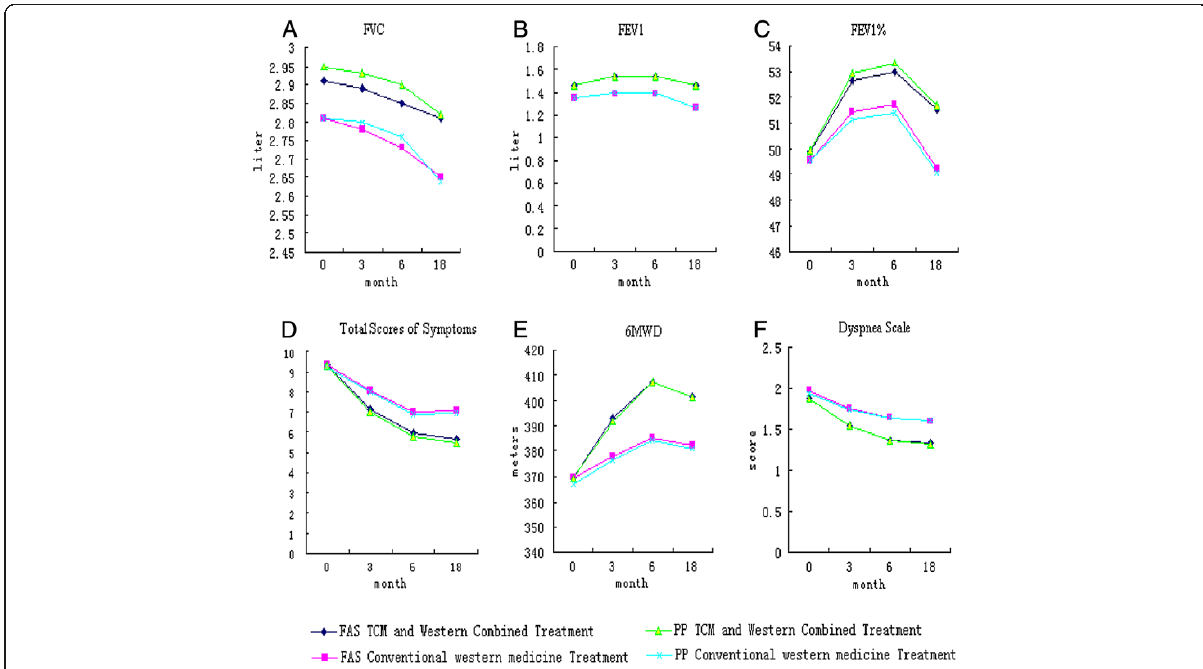
Figure 2 Comparison of the results of FVC, FEV1, FEV1%, Total Scores of symptoms, 6MWD and Dyspnea